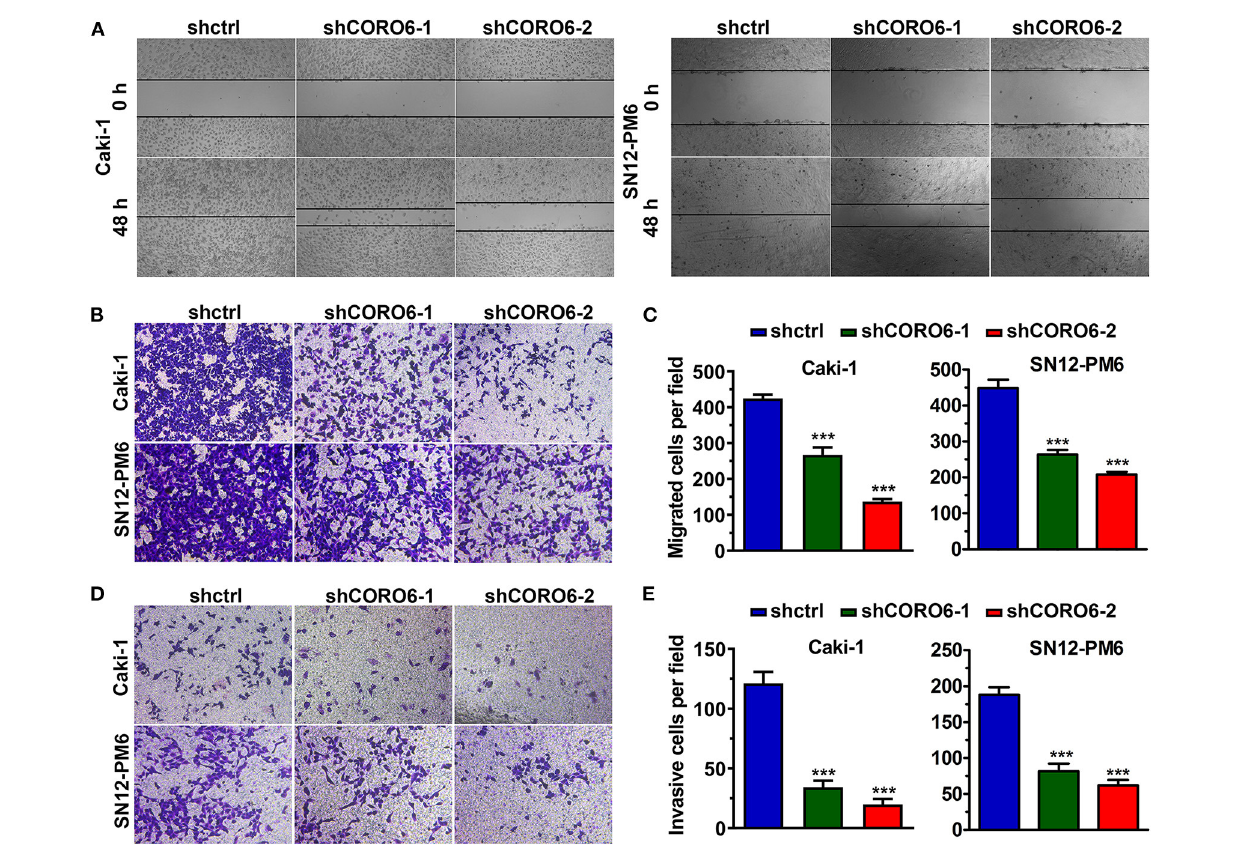
FIGURE 6 | CORO6 promoted ccRCC cell migration and invasion. (A) The wound healing assay showed that knockdown of CORO6 inhibited Caki-1 and SN12-PM6 cell migration. (B,C) The transwell migration assay revealed that CORO6 knockdown suppressed Caki-1 and SN12-PM6 cell migration. (B) Representative images of migrating cells. (C) Statistical analysis of (B) . (D,E) CORO6 knockdown significantly suppressed the invasion ability of Caki-1 and SN12-PM6 cells. (D) Representative images of invading cells. (E) Statistical analysis of (D) . *** P <